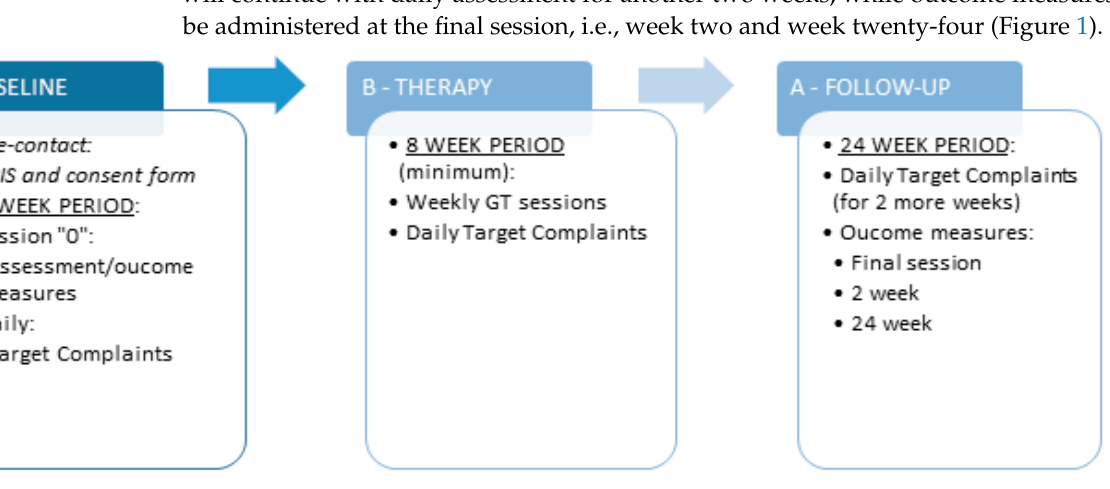
Figure 1. ABA design of the